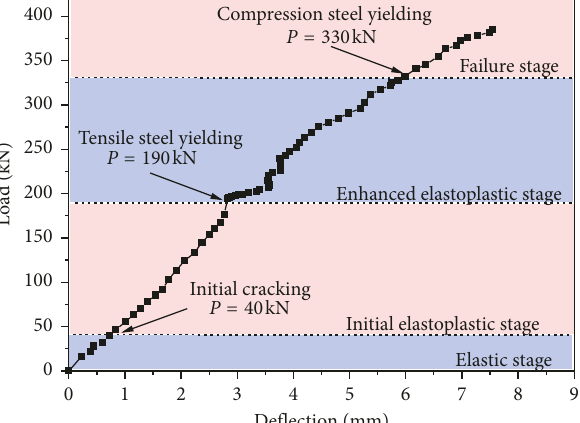
Figure 8: Load-deflection behavior of the L/4